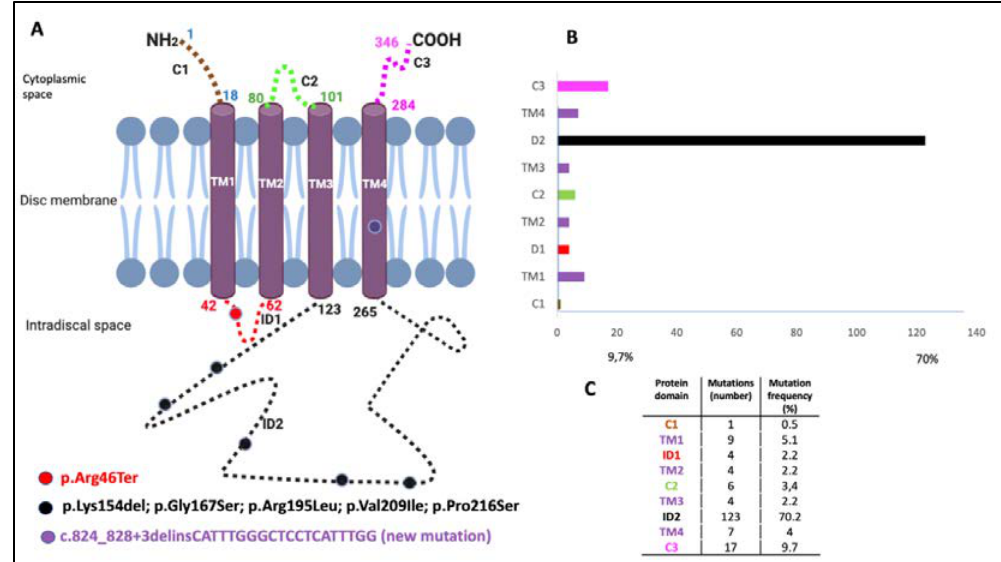
Figure 1. Location of identified mutations on the Peripherin-2 (PRPH2) protein and the frequency and location of all reported PRPH2 gene mutations. The PRPH2 protein scheme shows the location of the identified mutations. ( A ) The PRPH2 peptide chain shows extradiscal (C1, C2, and C3), transmembrane (TM1, TM2, TM3, and TM4), and intradiscal space locations (ID1 and ID2). The numbering indicates the amino acid positions at the boundaries of the domains. The mutations identified in the patients are indicated by circles (i.e., red, p.Arg46Ter; black, p.Lys154del, p.Gly167Ser, p.Arg195Leu, p.Val209Ile, and p.Pro216Ser; and purple for the novel mutation c.824_828+3delinsCATTTGGGCTCCTCATTTGG). ( B ) Representation of the location ( C ) and the frequency and number of all reported PRPH2 mutations are based on the Human Gene Mutation Database (HGMD 2020.1).